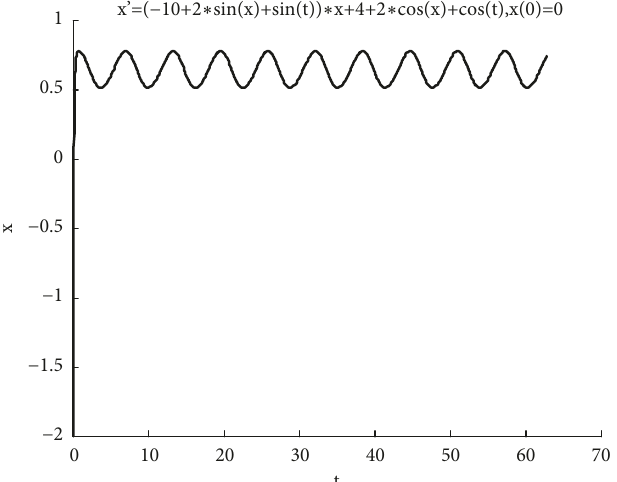
Figure 1: The solution curve of (73) with initial value 𝑥(0) = 0 .